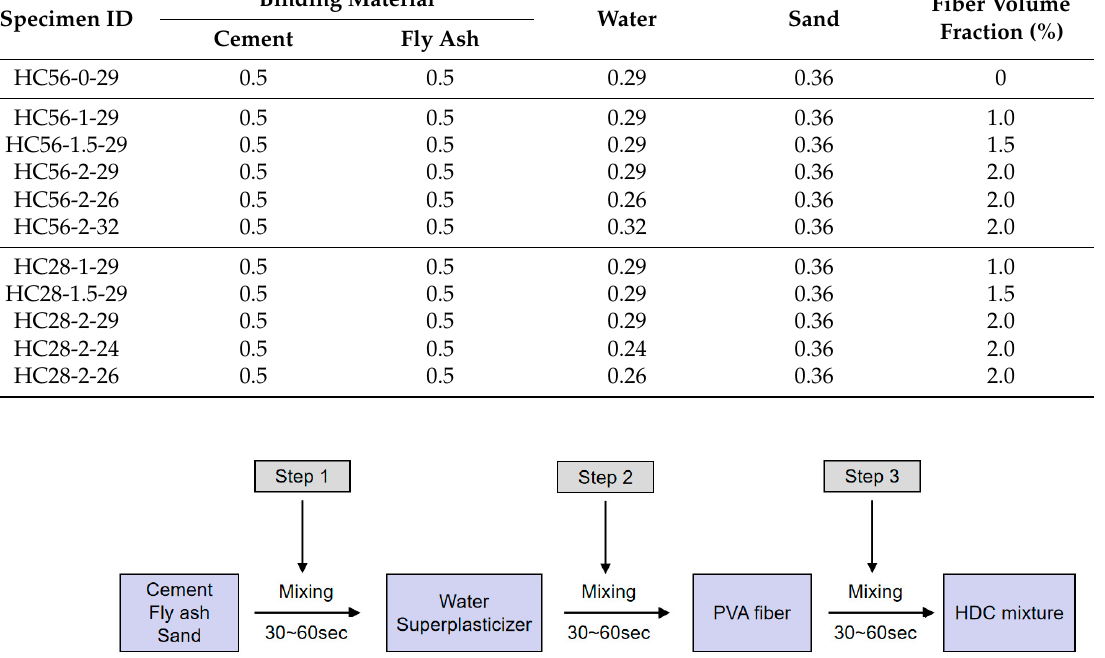
Table 2. Mixture proportions of HDC.